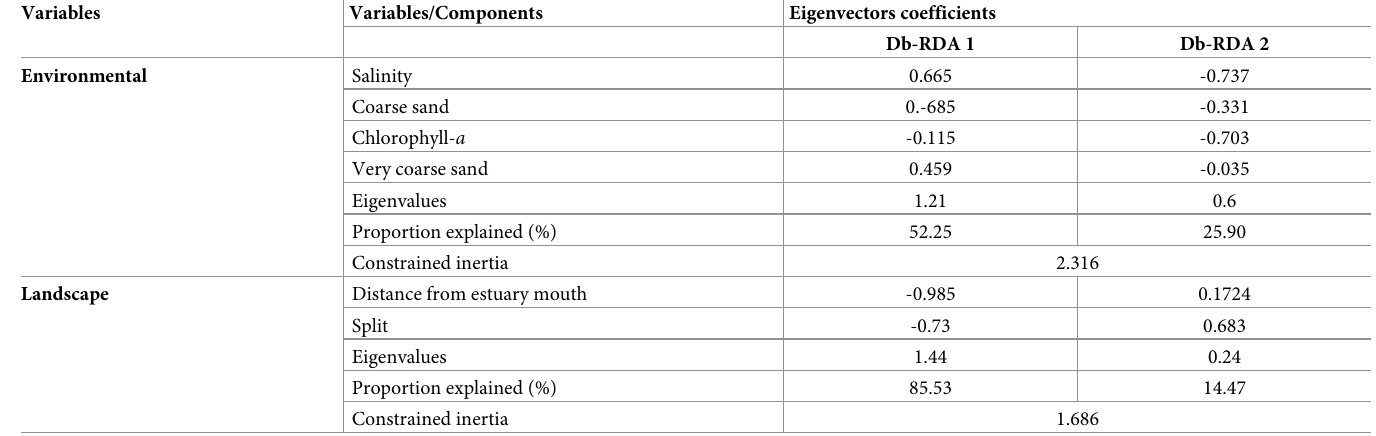
Table 3. Distance-based redundancy analysis (db-RDA) results for relationships of environmental and landscape variables with fish assemblage β -diversity in Mamanguape